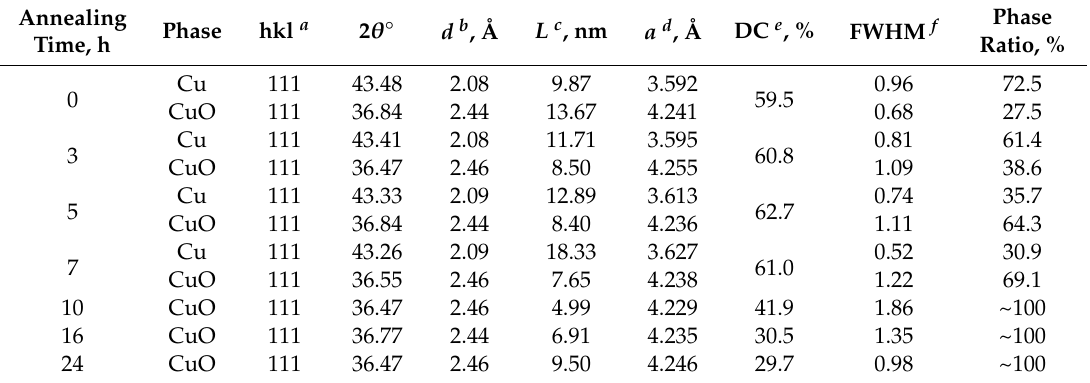
a Miller indices for corresponding planes, b spacing between planes, c average crystallite size, d crystal lattice parameter, e degree of crystallinity, f full width at half